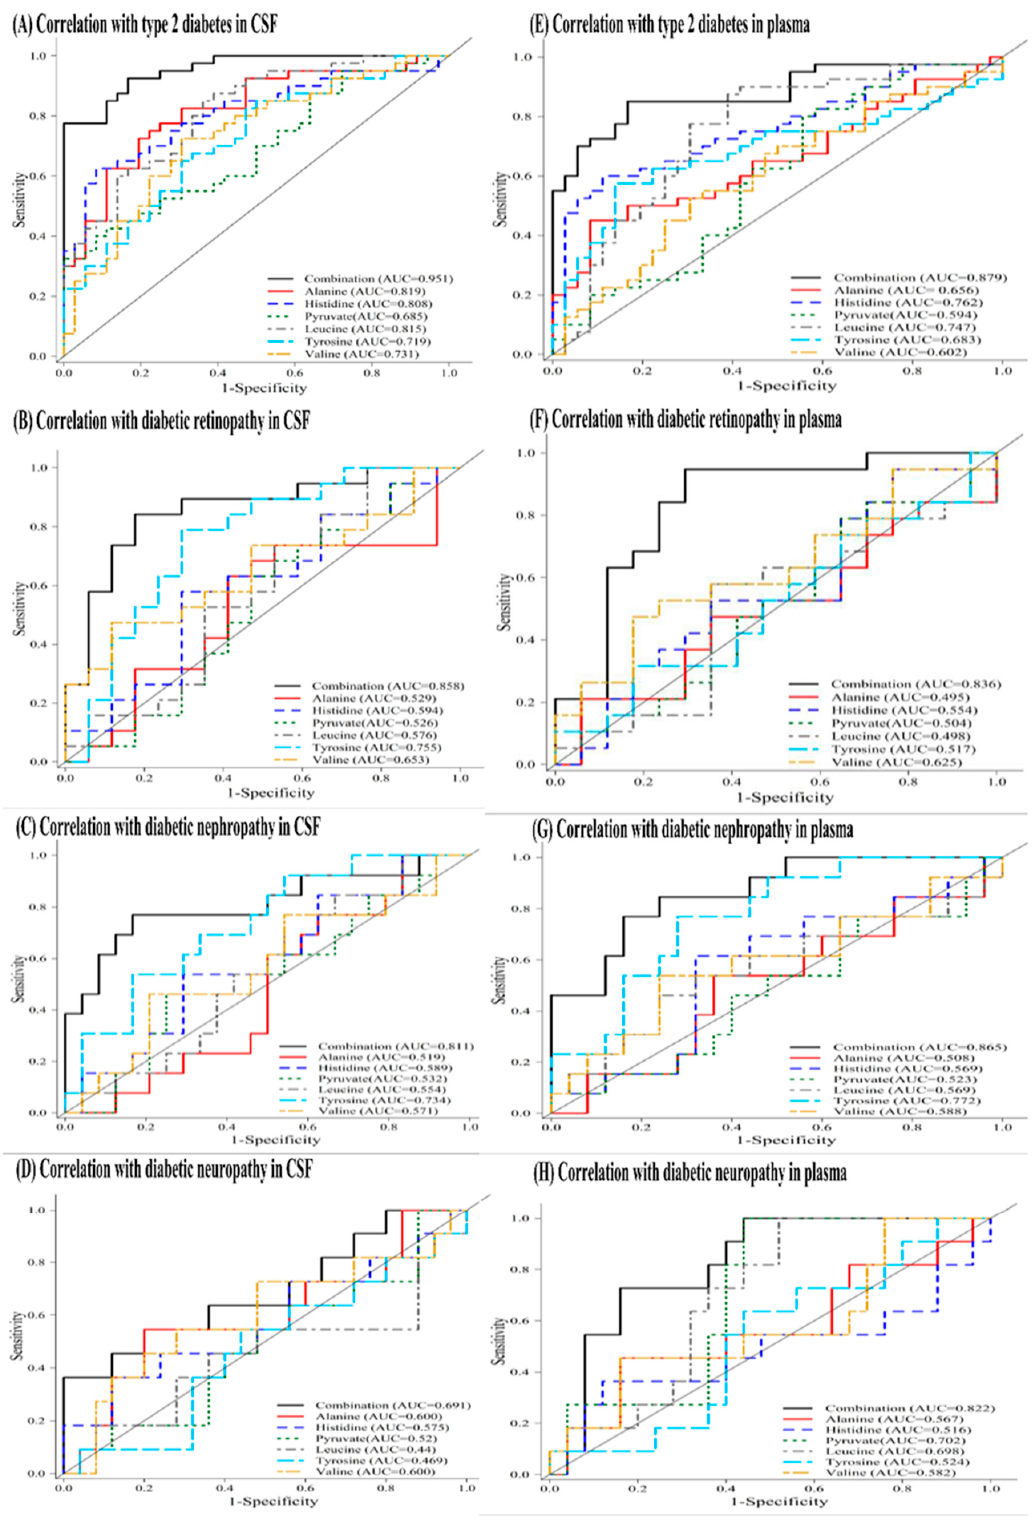
Figure 4. Receiver operating characteristic (ROC) curve of six-metabolite combination for correlation with the presence of type 2 diabetes and diabetic microangiopathy (retinopathy, nephropathy, and neuropathy) in CSF ( A–D ) and plasma ( E–H ) samples. The six-metabolite combination consists of alanine, histidine, leucine, pyruvate, tyrosine, and valine. Each subfigure consists of seven correlation curves including six single metabolite and their combination.